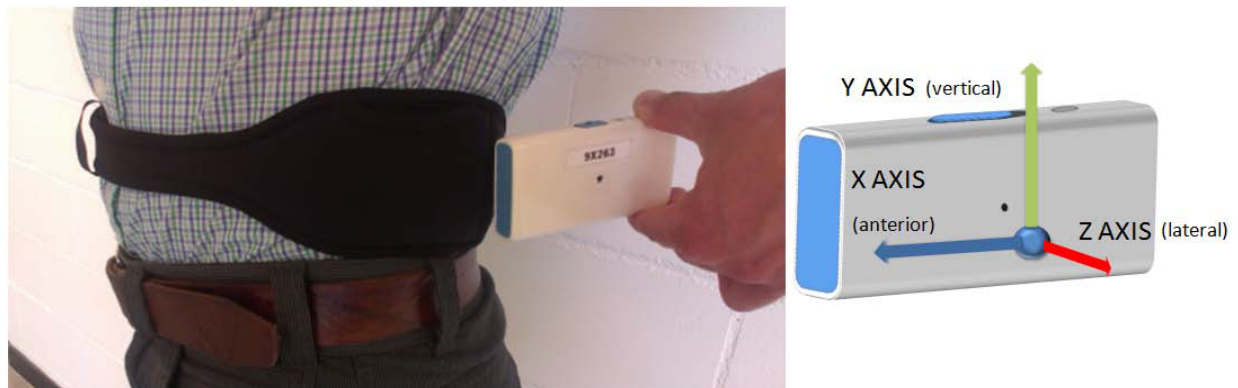
Figure 1. 9 × 2 sensor and its specially design neoprene belt.